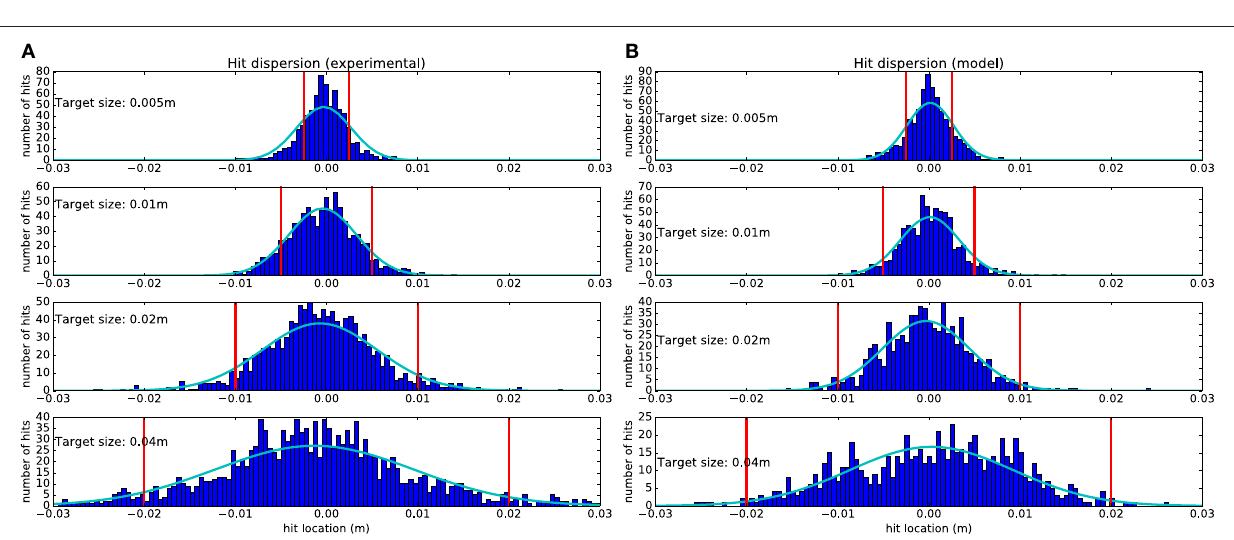
FIGURE 4 | Hit dispersion diagram obtained from 1,500 trajectories starting from 15 points (see Figure 5B ), for each target size. (A) Recorded from subjects. (B) Obtained from the model. The vertical red lines denote the lateral target boundaries. Dark blue histograms are obtained by counting all the trajectories that hit the target within a 0.5 millimeter range. Light blue Gaussians are fitted to the